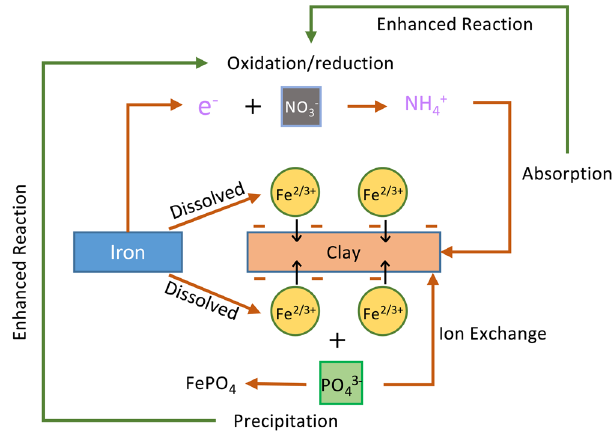
Figure 8. Schematic diagram of interactions between clay and soluble ions in the treatment process. Nitrate and phosphate are attracted by ferrous/ferric ions which are tied to the negatively charged clay surface. It forms the ion aggregation that accelerates the nitrate reduction and phosphorus precipitation with effective ammonia